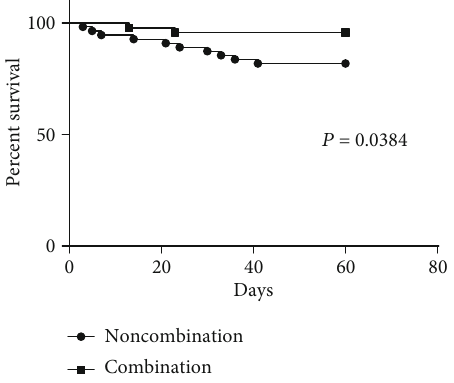
Figure 3: Survival in AIDS-PCP patients exhibiting mild disease states ( PaO /FiO > 200mmHg ) after treatment. Two subgroups 2 2 were considered based on either combined echinocandin treatment or noncombined